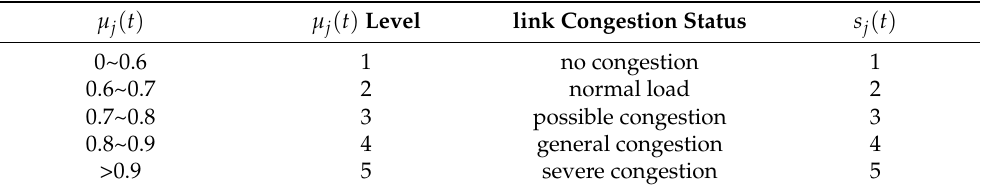
Table 3. The congestion level of the link bandwidth occupancy